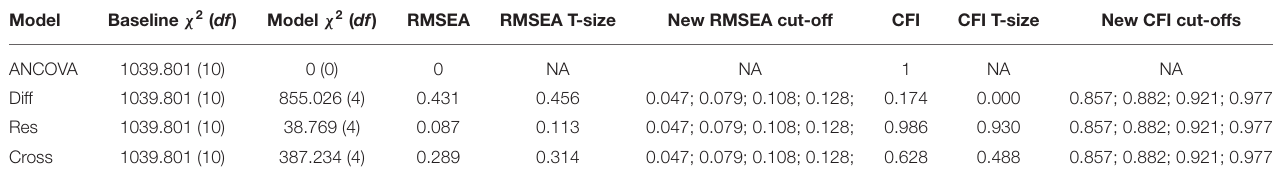
TABLE 5 | Model fit information for LCS specification of two-wave mediation models applied to empirical example.